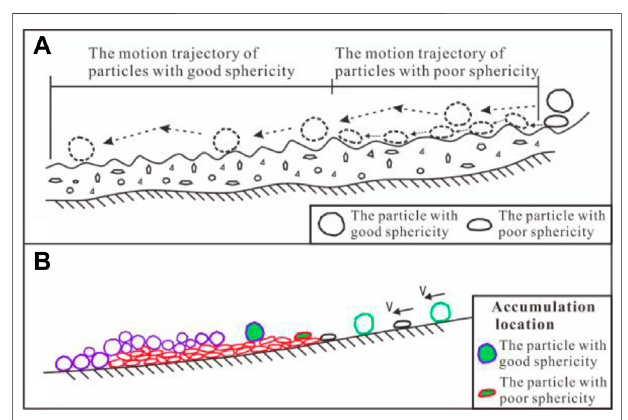
FIGURE 16 | Differential movement phenomenon and accumulation morphology of debris particles with different sphericity. (A) Schematic diagramofthemotiontrajectoryofdebrisparticleswithdifferentsphericity. (B) Schematic diagram of debris fl ow accumulation morphology.